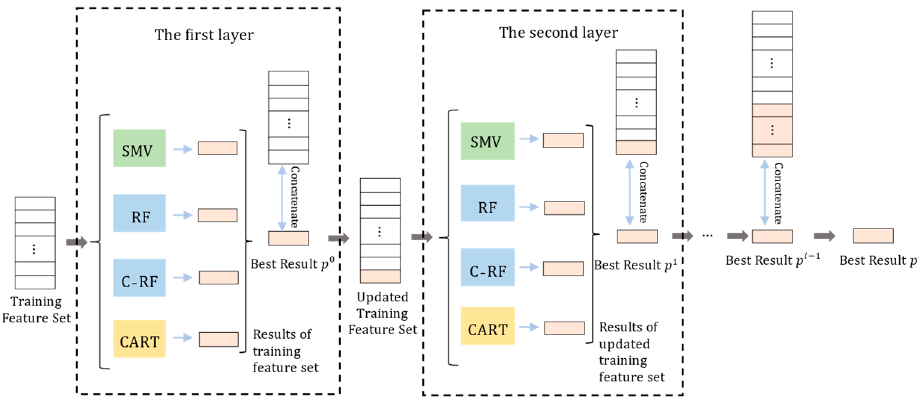
Figure 4. The training process of ensemble learning (each rectangle in the training feature set represents a concatenated vector).